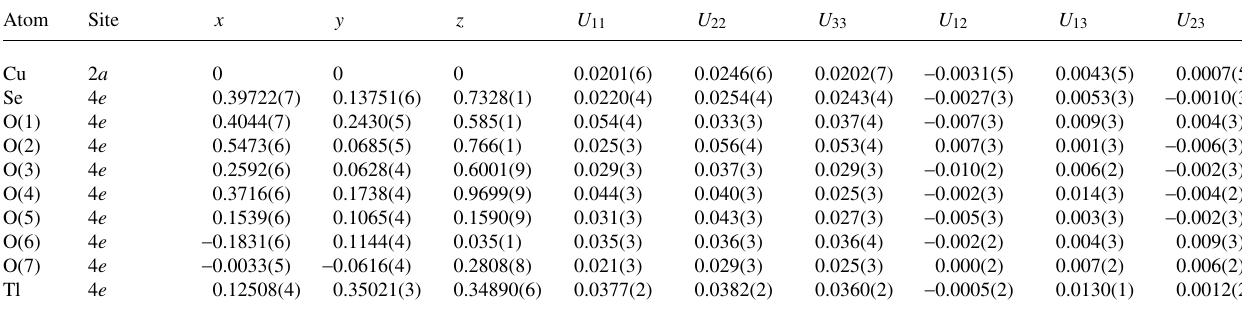
Table 15. Atomic coordinates and displacement parameters (in Å 2 )